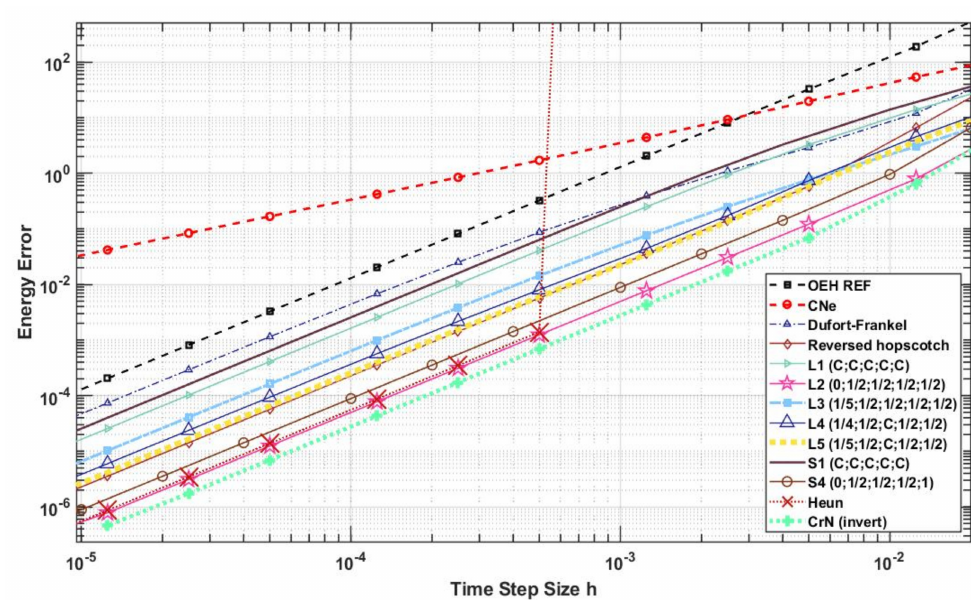
Figure 5. Energy errors as a function of the time step size for the first (moderately stiff) system, in the case of the original OEH method (OEH REF), the new algorithms L1–L5, and several other methods.